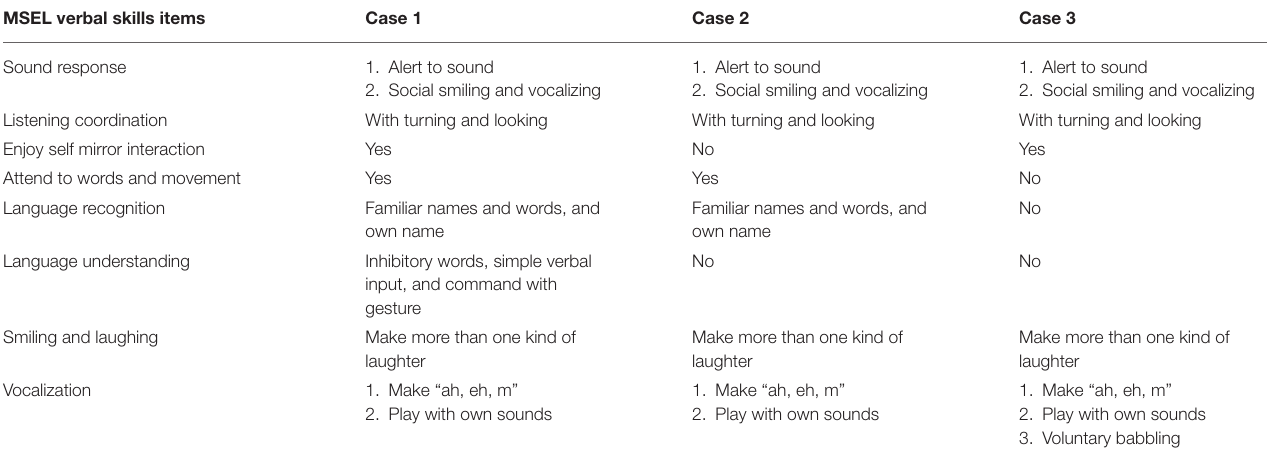
TABLE 4 | Developmental performance of MSEL verbal skills in the subjects with FOXG1-related